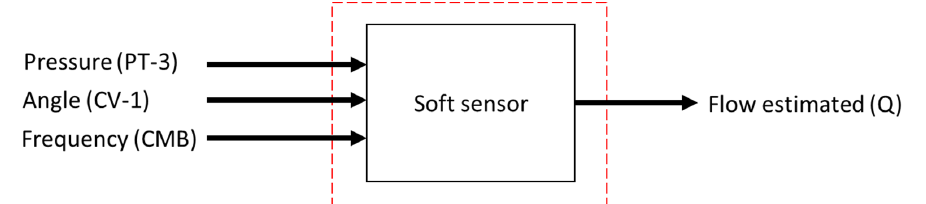
Figure 8. Diagram of Multi-layer Feedforward Perceptron Backpropagation ANN without feedback, with three input vectors and an output.